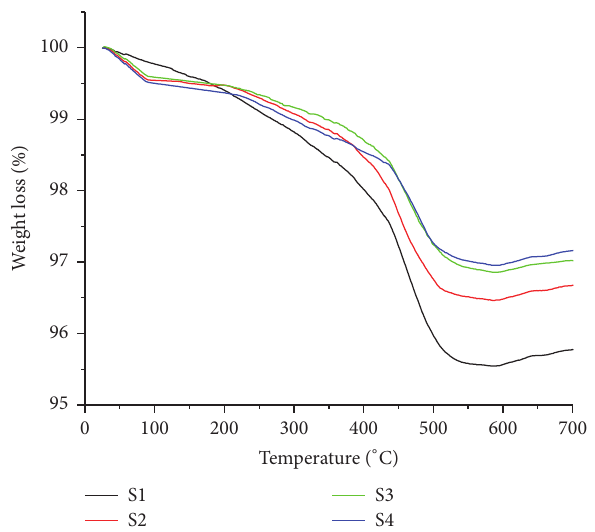
Figure 9: TGA curves of S1–S4 compounds in nitrogen.